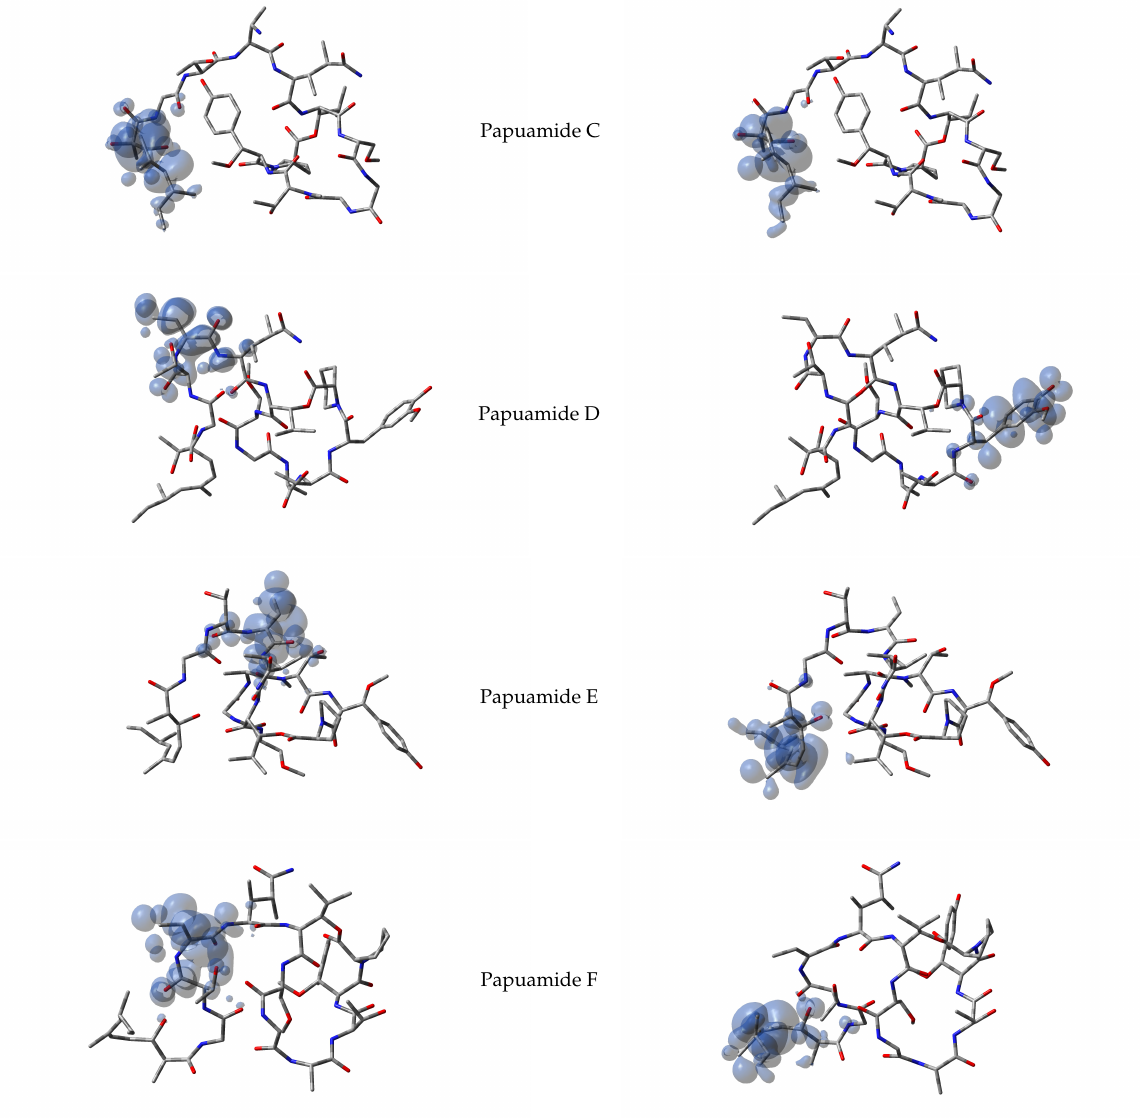
Figure 2. Graphical representation of the Electrophilic P + ( r ) ( left column ) and Nucleophilic P − ( r ) Parr functions ( right column ) of Papuamides